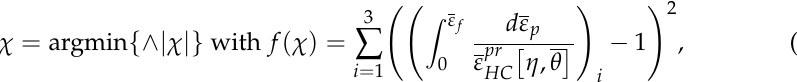
specimen rotated with increasing the loading step.